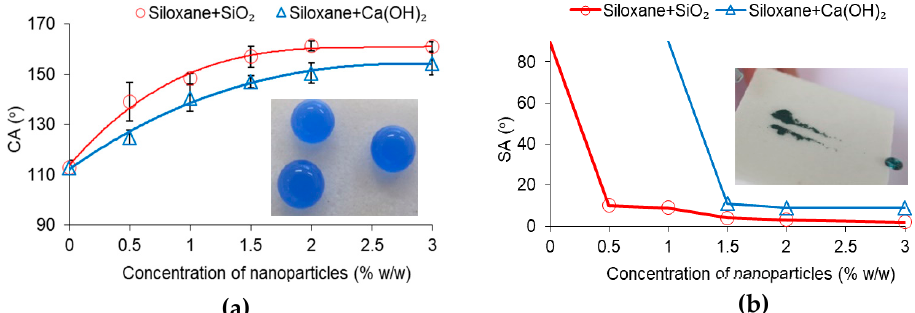
Figure 3. ( a ) Static contact angle (CA) and ( b ) sliding angle (SA) vs the nanoparticle concentration. Data points were ( a ) fitted with polynomial functions and ( b ) connected with lines to guide the eye. Coatings prepared using < 0.5 % w/w SiO 2 and < 1.5 % w/w Ca(OH) 2 were pinned on the surfaces; therefore, they correspond to a theoretical SA of 90°. Photographs showing ( a ) resting drops and ( b ) the self-cleaning process were taken for marble specimens that were coated with superhydrophobic and water repellent composite coatings. The latter were prepared using siloxane and 3 % w/w Ca(OH) 2 nanoparticles.